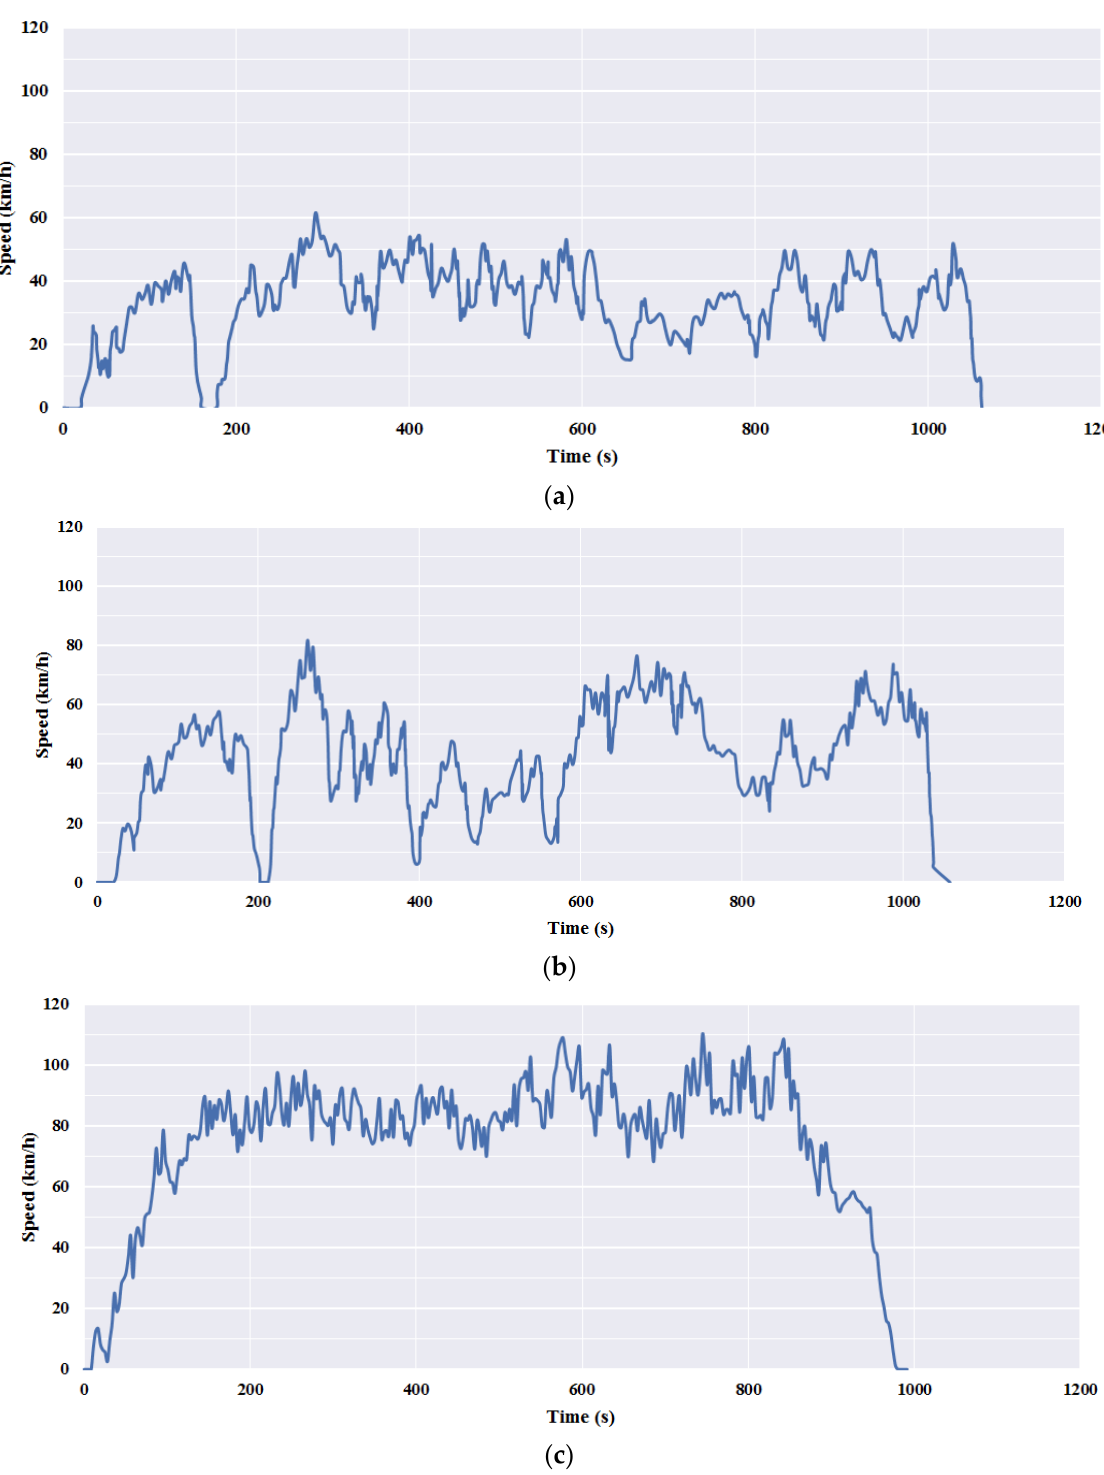
Figure 10. The typical vehicle driving cycles of different speed intervals; ( a ) The typical vehicle driving cycles under low-speed driving condition; ( b ) The typical vehicle driving cycles under middle-speed driving condition; ( c ) The typical vehicle driving cycles under high-speed driving condition